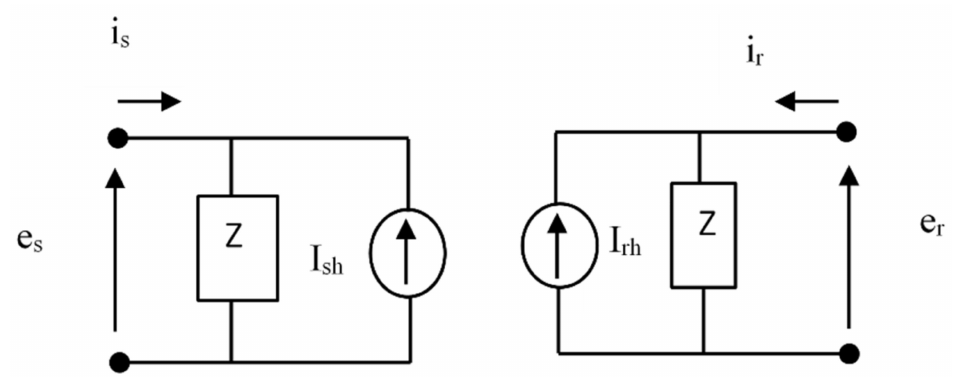
Figure 1. Two port network of distributed parameter transmission line